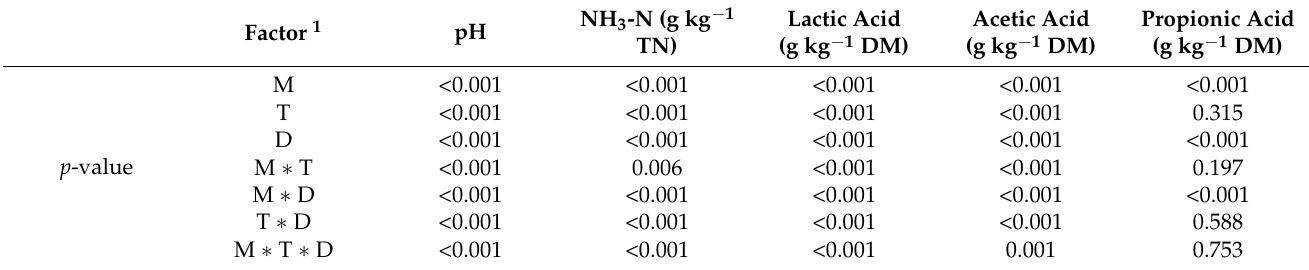
Table 3. Effect of different study factors and their interaction on the fermentation quality of Stylosan- thes silage.